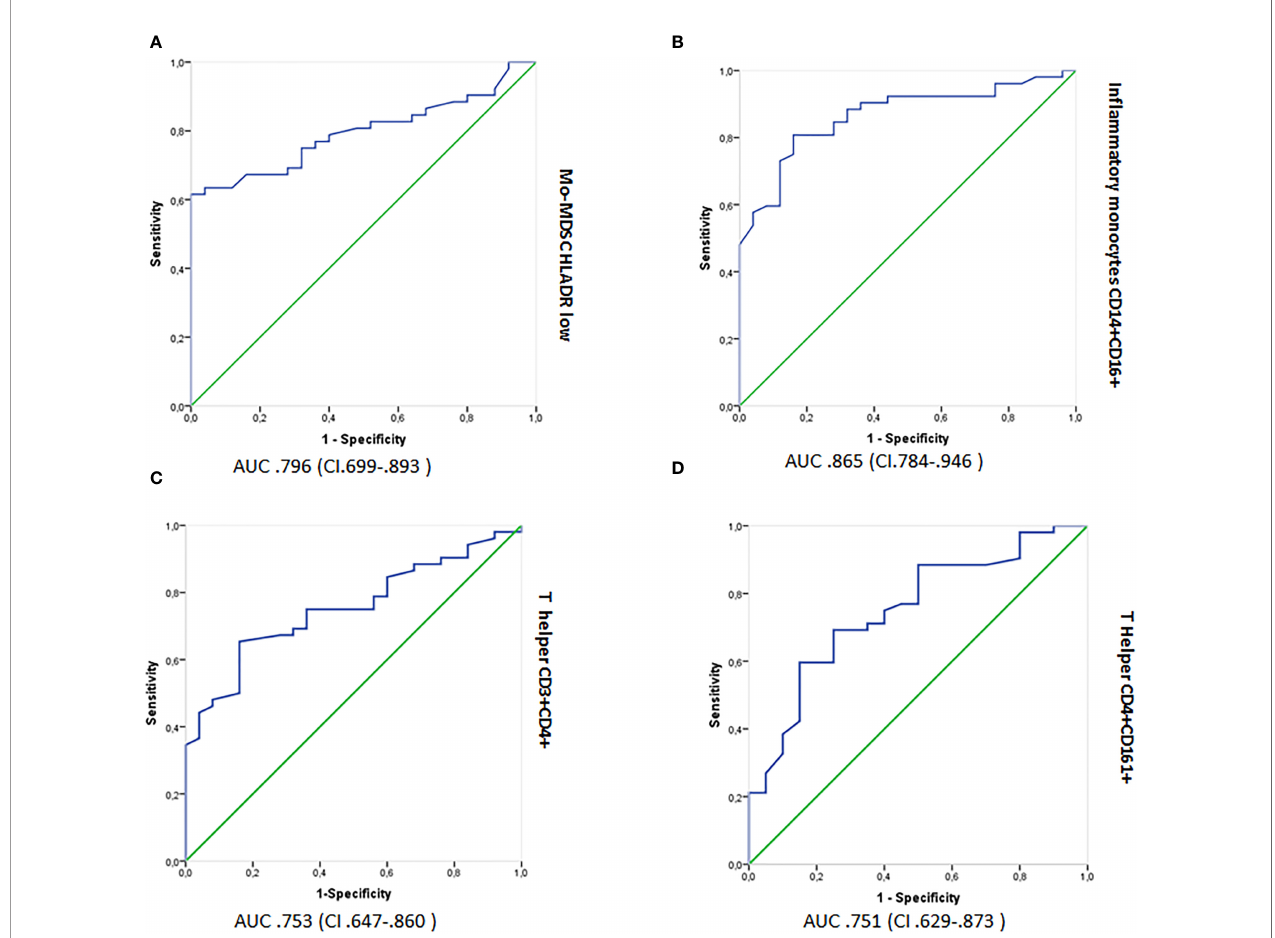
FIGURE 4 | Logistic regression analyses showing ROC outputs for patients with RRMS plotted against HCs. AUC, with 95% con fi dence intervals (CI), is provided for each parameter. The surface expression of parameters in RRMS patients are combined as true positives (n = 52) and plotted against HCs (n = 26) as true negatives. The diagonal dividing the ROC represents random events. A logistic regression analysis of combined parameter results was performed for “ all parameters, ” parameters with AUC >0.70 and >0.75. ROC, receiver operating characteristic; AUC, Area under the curve; RRMS, relapsing – remitting MS; HCs, healthy controls. (A) Mo-MDSCs CD14+/HLADR − /low, (B) in fl ammatory monocytes, CD14+CD16+, (C) T helper CD3+CD4+, and (D) T helper